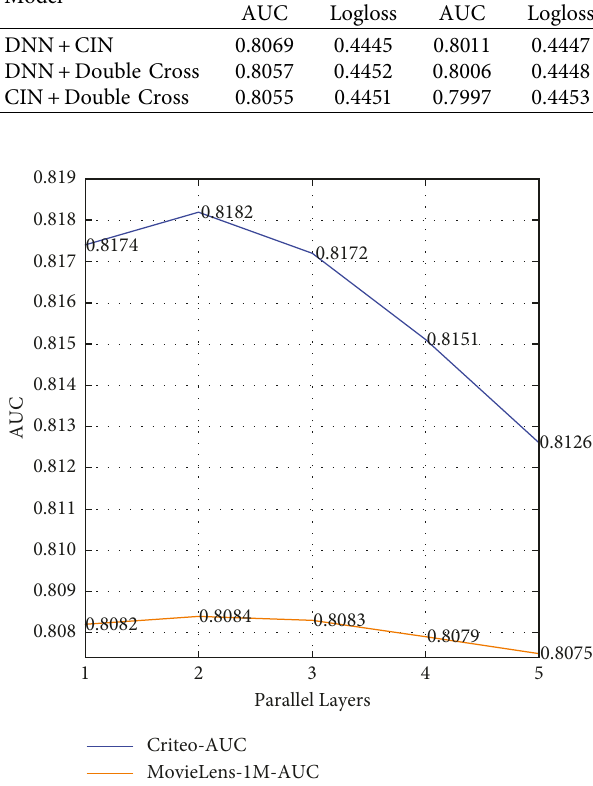
Figure 9: The parallel layers of AUC in model CCPIN.